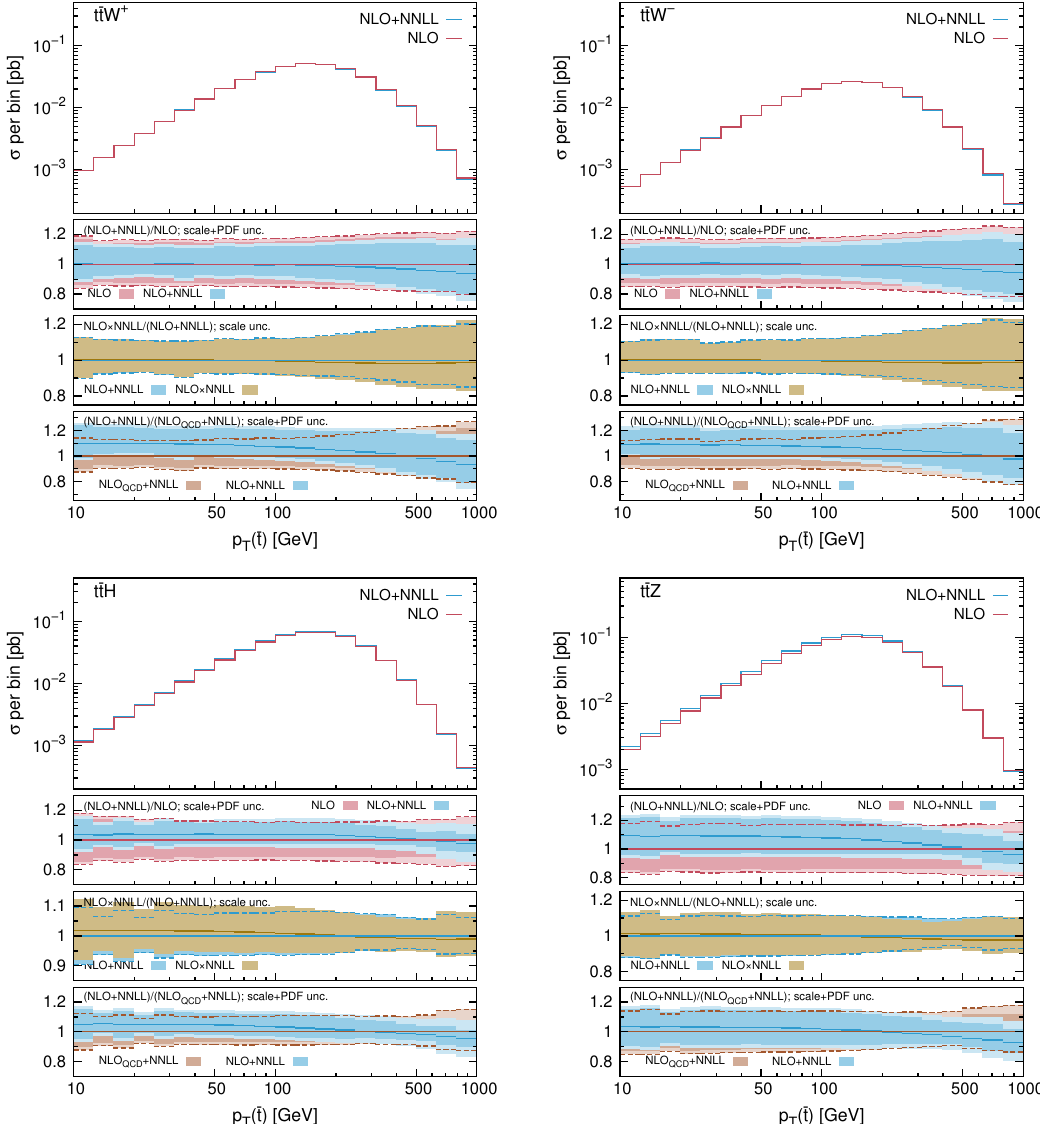
Figure 5 . Distributions di(cid:11)erential w.r.t. the transverse momentum of the antitop quark. Same structure as in (cid:12)gure